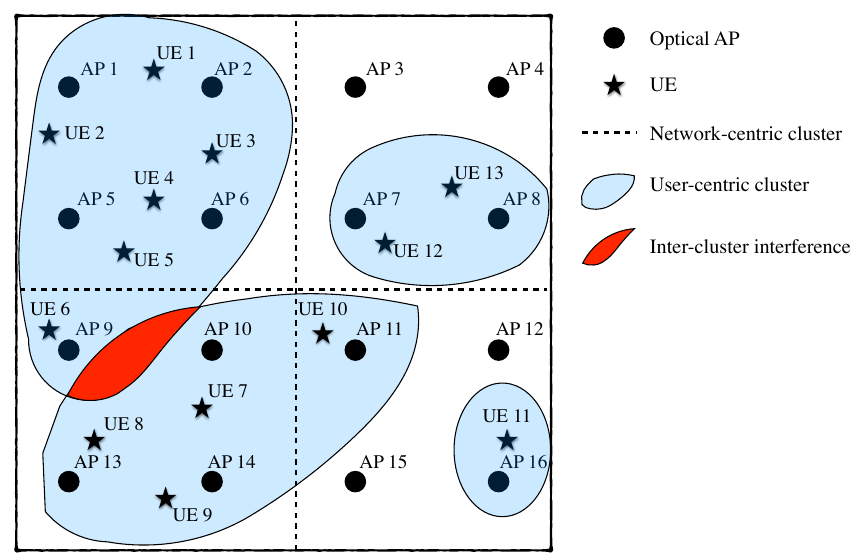
Figure 20. Example of user-centric cell